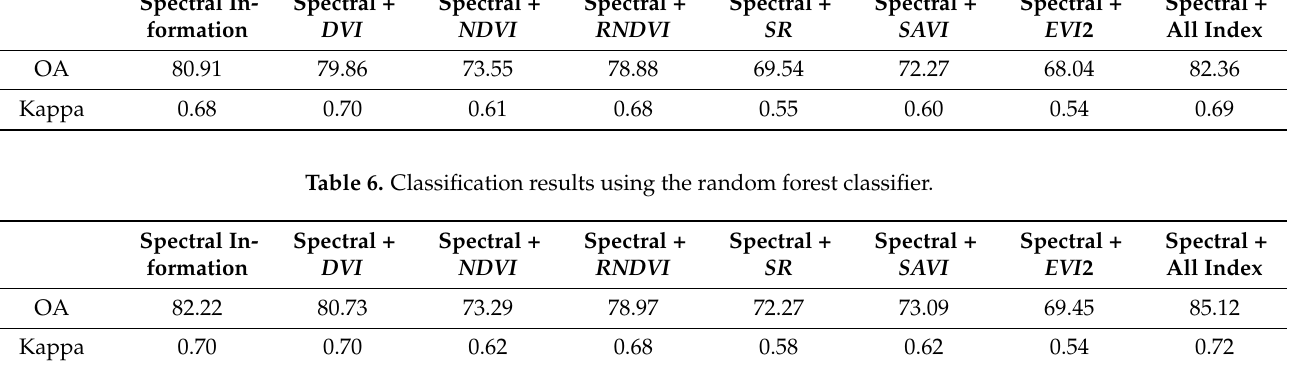
Table 6. Classification results using the random forest classifier.